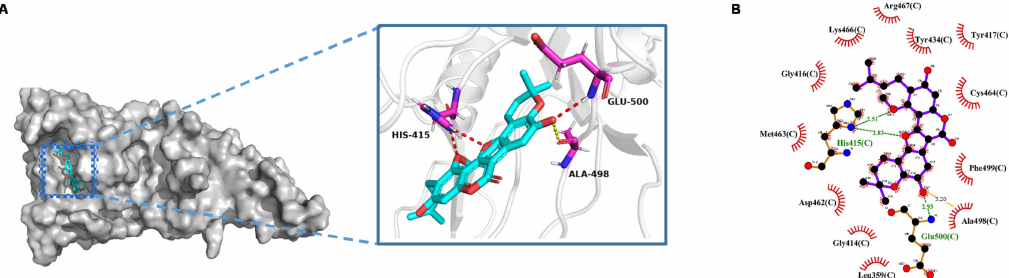
Figure 5. Calculated binding mode of lesbicoumestan with MALT1. ( A ) Overall and local structure of the binding mode. ( B ) 2D presentation of hydrophobic interactions between amino acid residues and lesbicoumestan.